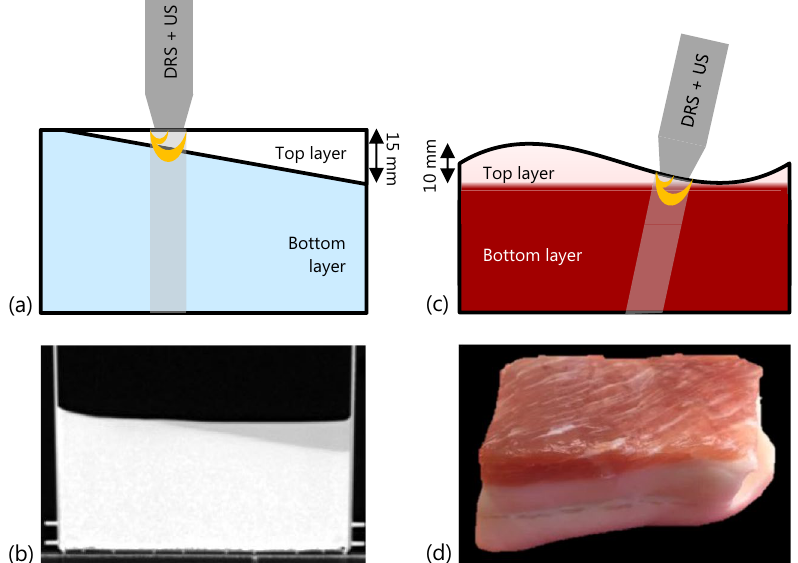
Figure 1. ( a ) Schematic representation of an artificial phantom, consisting of two different homogeneous layers with a gradually increasing top layer thickness; ( b ) axial view of CT-scan of the artificial phantom; ( c ) schematic representation of two-layered animal tissue, with a varying top layer thickness; ( d ) picture of a piece of animal tissue, with a top layer of muscle tissue and a bottom layer of fat